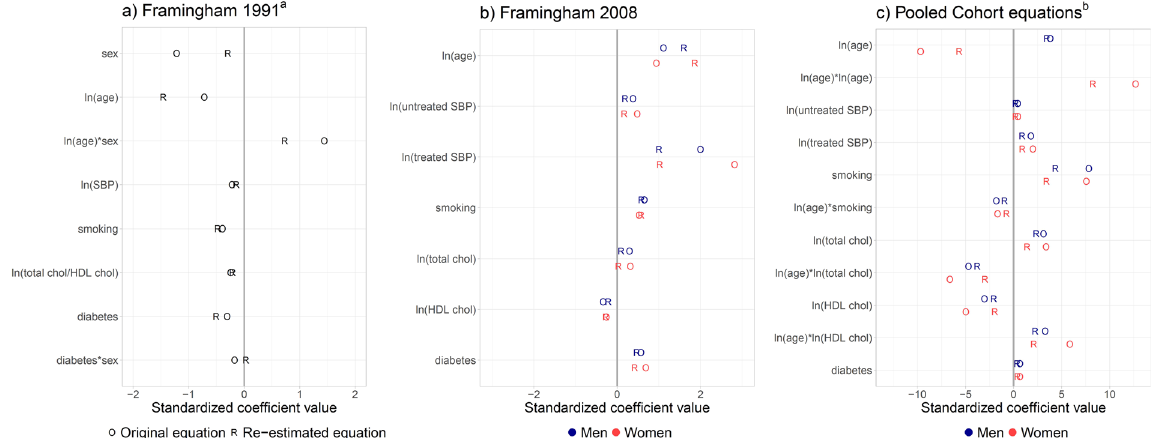
Figure 2. Forest-plot comparing standardized re-estimated (R) to standardized original (O) regression coefficients. Note, the different scale of standardized regression coefficients in the last panel. a ’ln(age)’ represents the natural logarithm of age; ‘ln(age) * sex’ is a pair-wise interaction of ln(age) with sex. b The equation for men does not include a term for ‘ln(age) * ln(age)’.